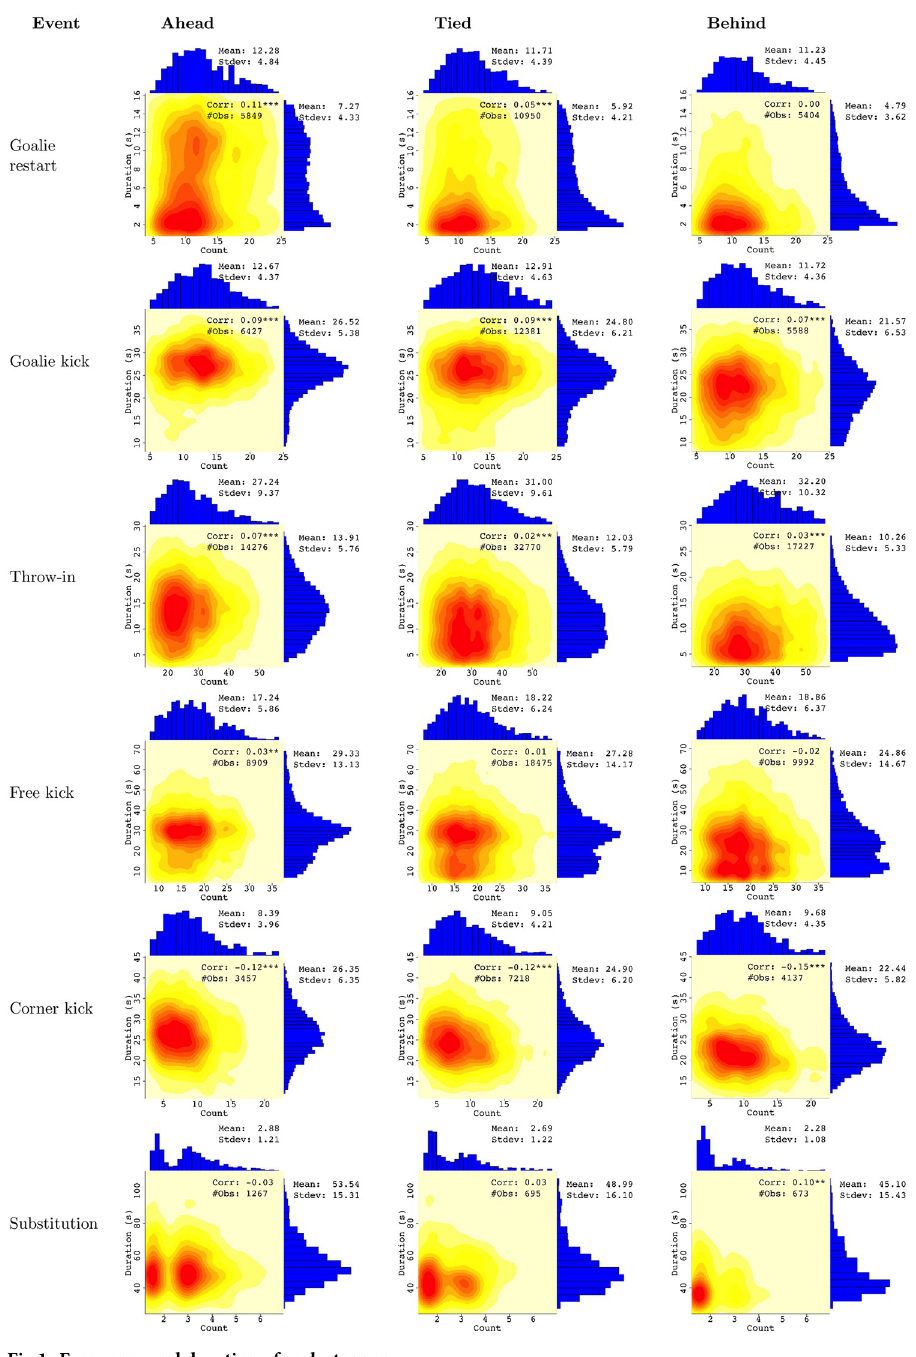
Fig 1. Frequency and duration of each